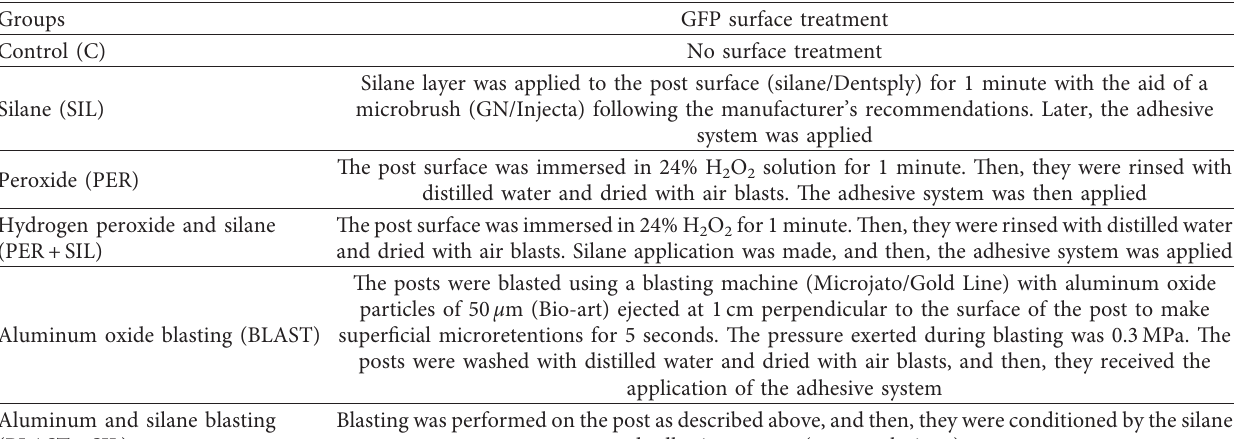
Table 1: Glass fiber post surface treatment